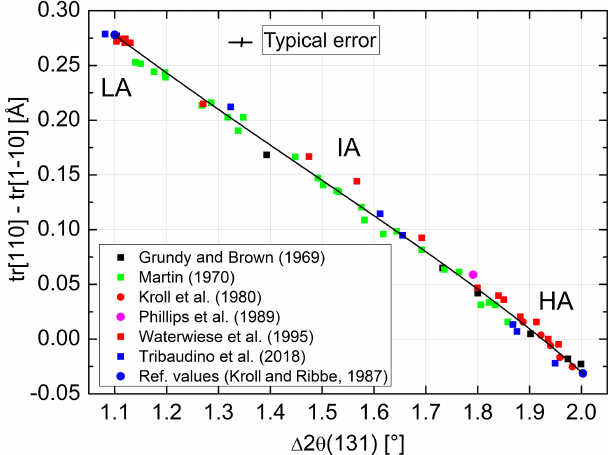
Figure 7. Calibration of (cid:49) tr [ 110 ][ Å ] ≡ tr [ 110 ]− tr [ 1 ¯ 10 ] versus (cid:49) 2 θ( 131 ) [ ◦ ] (Eq.